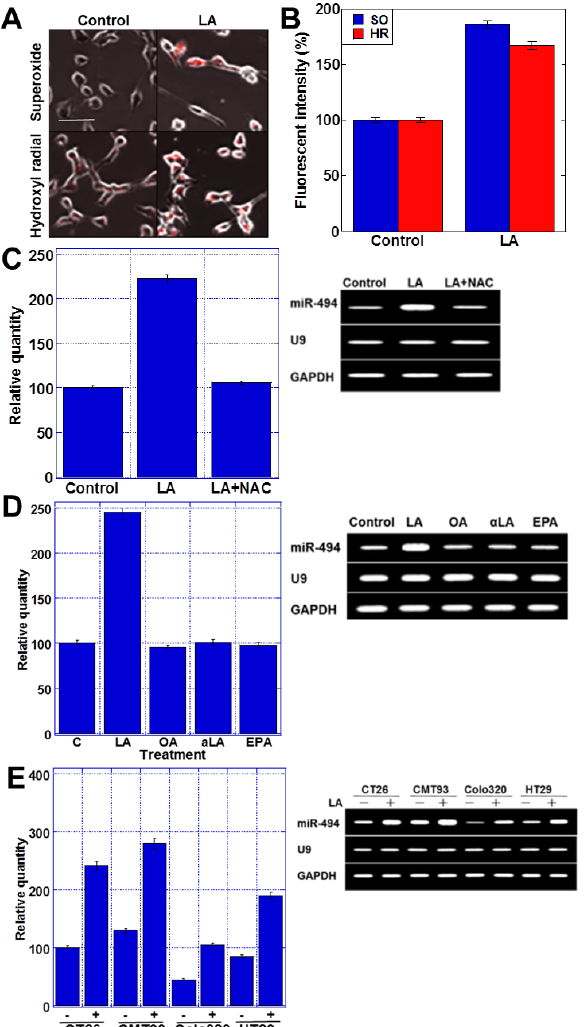
Figure 3. LA-induced mitochondrial ROS upregulated miR-494. ( A ) Mitochondrial superoxide and hydroxy radicals visualized by fluorescent dye probes. Scale bar, 50 μm. ( B ) Fluorescent intensities of mitochondrial superoxide and hydroxy radicals. ( C ) Expression of miR-494 in CT26 cells treated with LA and/or NAC examined by quantitative RT-PCR. (Right) Ethidium bromide image of RT-PCR. ( D ) Expression of miR-494 in CT26 cells treated with LA, oleic acid (OA, 35 μg/mL), α-linolenic acid (αLA, 35 μg/mL), and eicosapentaenoic acid (EPA, 40 μg/mL) for 48 h. (Right) Ethidium bromide image of RT-PCR. ( E ) Expression of miR-494 in CT26, CMT93, Colo320, and HT29 CRC cell lines was examined with or without LA treatment (35 μg/mL, 48 h). (Right) Ethidium bromide image of RT-PCR. Error bars, standard deviation from three independent trials. LA, linoleic acid; SO, superoxide; HR, hydroxy radical; NAC, N-acetyl-L-cysteine; GAPDH, glyceraldehyde-3-phosphate dehydrogenase.